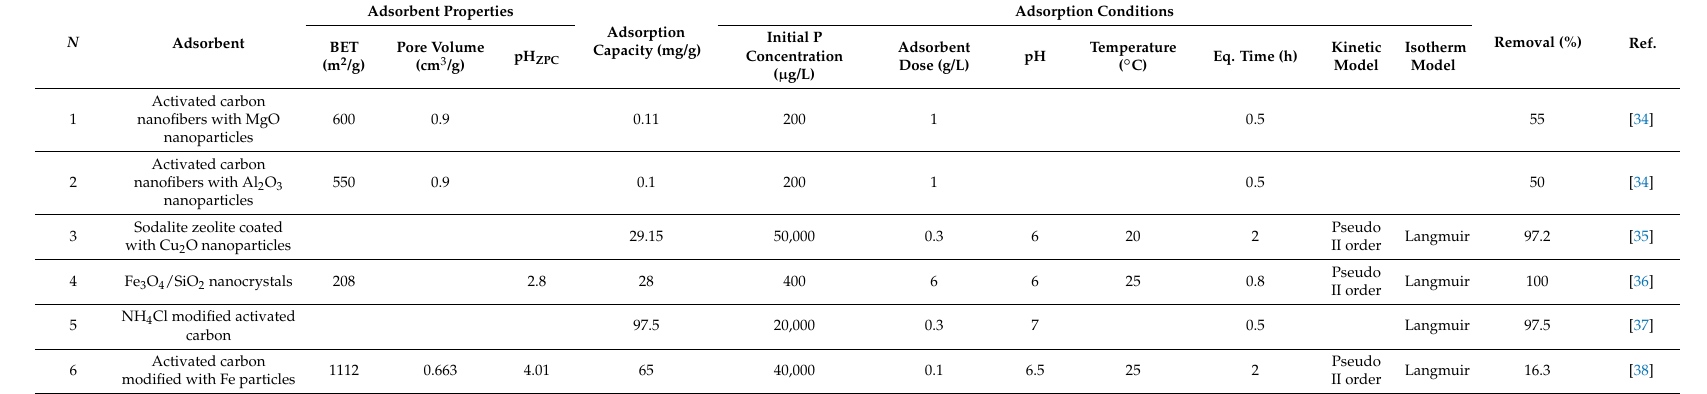
Table 3. Nanofibrous adsorbent properties and adsorption conditions for the removal of